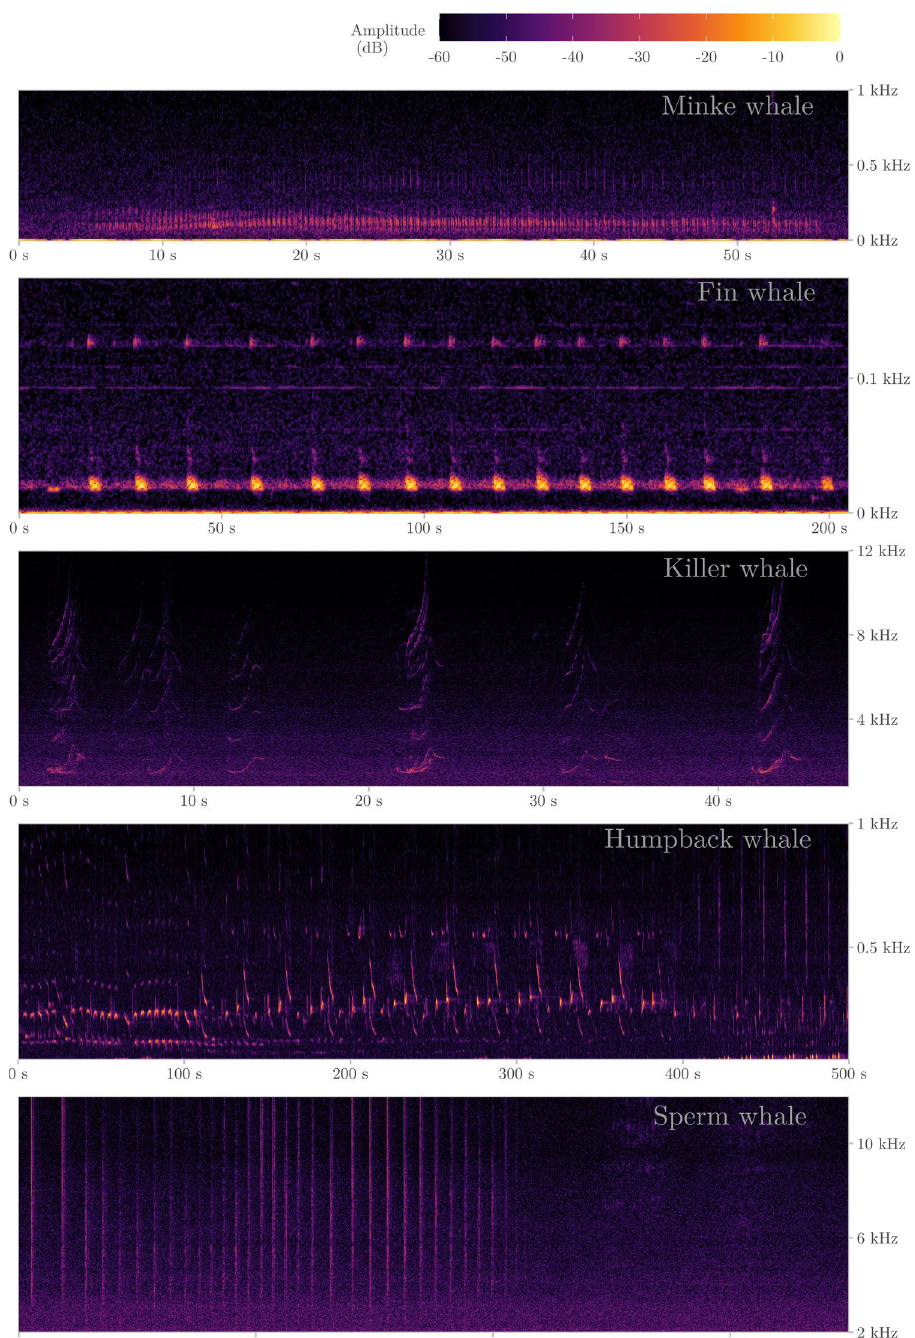
Figure 4. Spectrograms of five whale species detected in the acoustic dataset (all figures were obtained with Hanning window, fft size 4534 samples, and 50% overlap, with the exception of the fin whale which was done using an fft window size of 32,768 with 70% overlap, and the humpback whale with an fft window size of 8219 with 50%